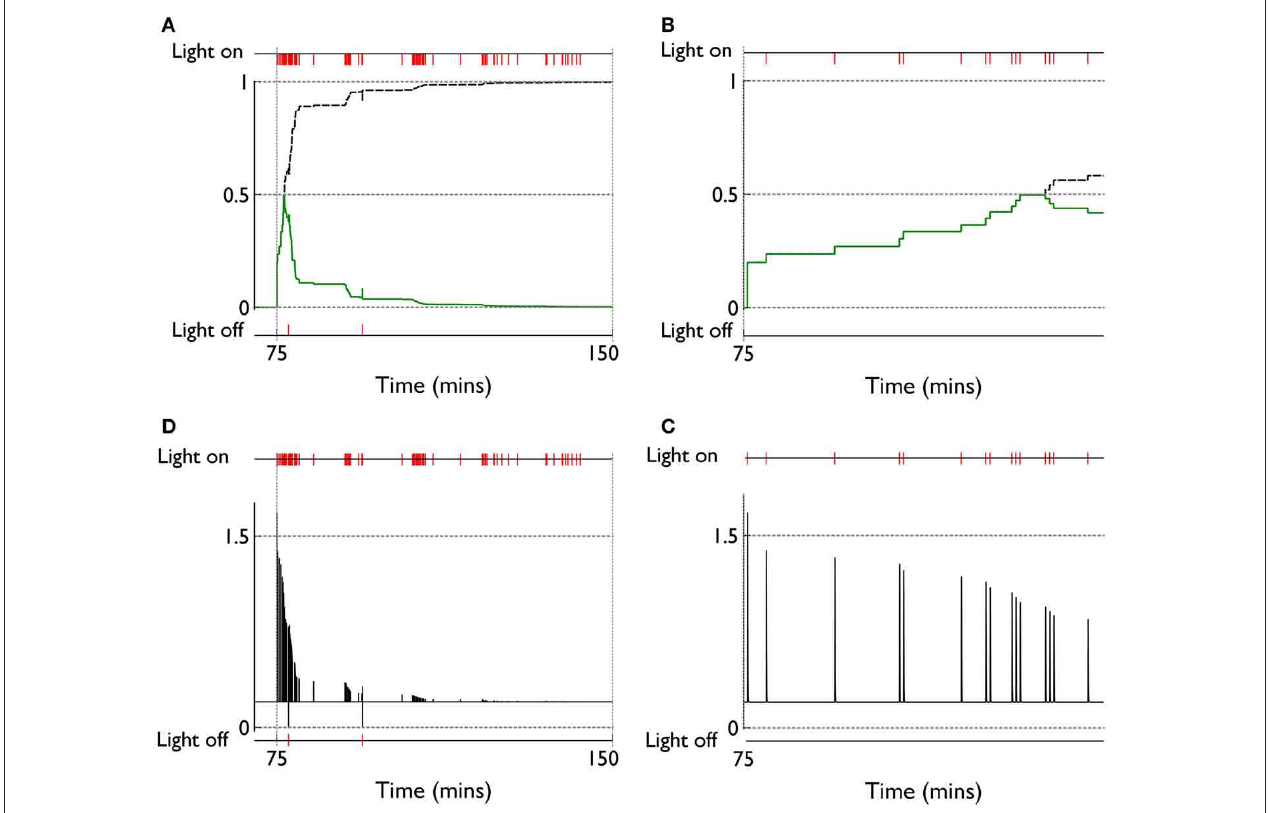
FIGURE 14 | Internal variables and phasic dopamine signals for a model with novelty salience and prediction undergoing fixed interval training. (A,B) Show novelty salience and the prediction signal, and are counterparts to Figures 11B,C . (C,D) Show phasic dopamine and are counterparts to Figures 11A,D